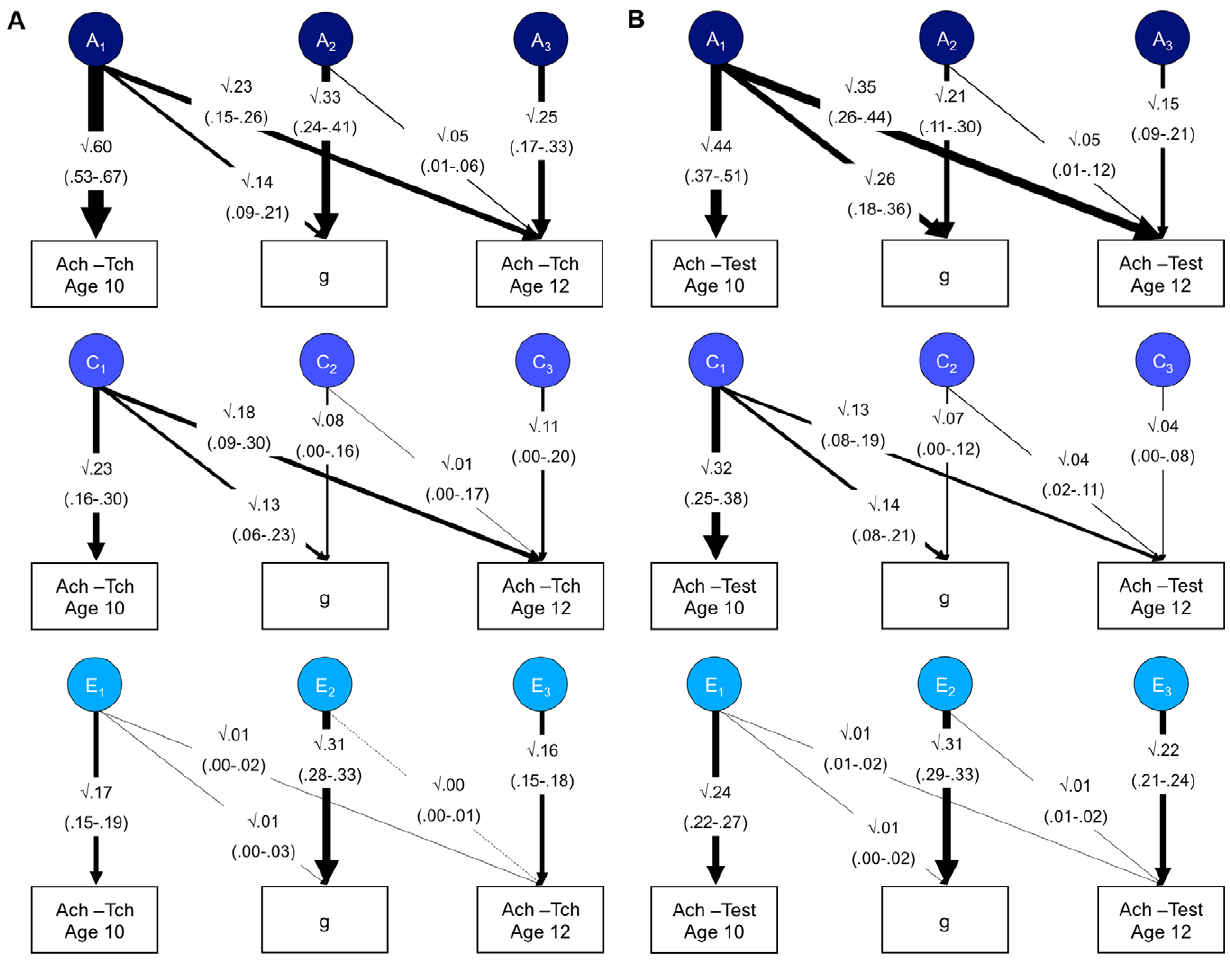
Figure 3. Trivariate analysis of 10-year achievement, general cognitive ability and 12-year achievement. Panel A= Teacher-rated achievement. Panel B= Test achievement. g= general cognitive ability; Ach-Tch = Teacher-rated achievement; Ach-Test = test achievement; A= additive genetic; C= Shared environment; E= Non-shared environment. The figures represent the results from a standardized Cholesky decomposition of twin data. 95% confidence intervals of the path estimates are shown in parentheses. The first factors assess genetic (A 1 ), shared (C 1 ) and non-shared environmental (E 1 ) influences on 10-year achievement, some of which may also influence g and 12-year achievement. The second factor estimates influences on 12-year g that are independent of the influences on 10-year achievement, and which may also influence 12-year achievement (A 2 , C 2 and E 2 ). The third factor (A 3 , C 3 and E 3 ) estimates influences on 12-year achievement that are independent of those on 10-year achievement and 12-year g. Results indicate significant residual genetic influence on school achievement, even when the genetic and environmental co-variance with previous achievement and general cognitive ability has been removed (see the A 3 path estimates).